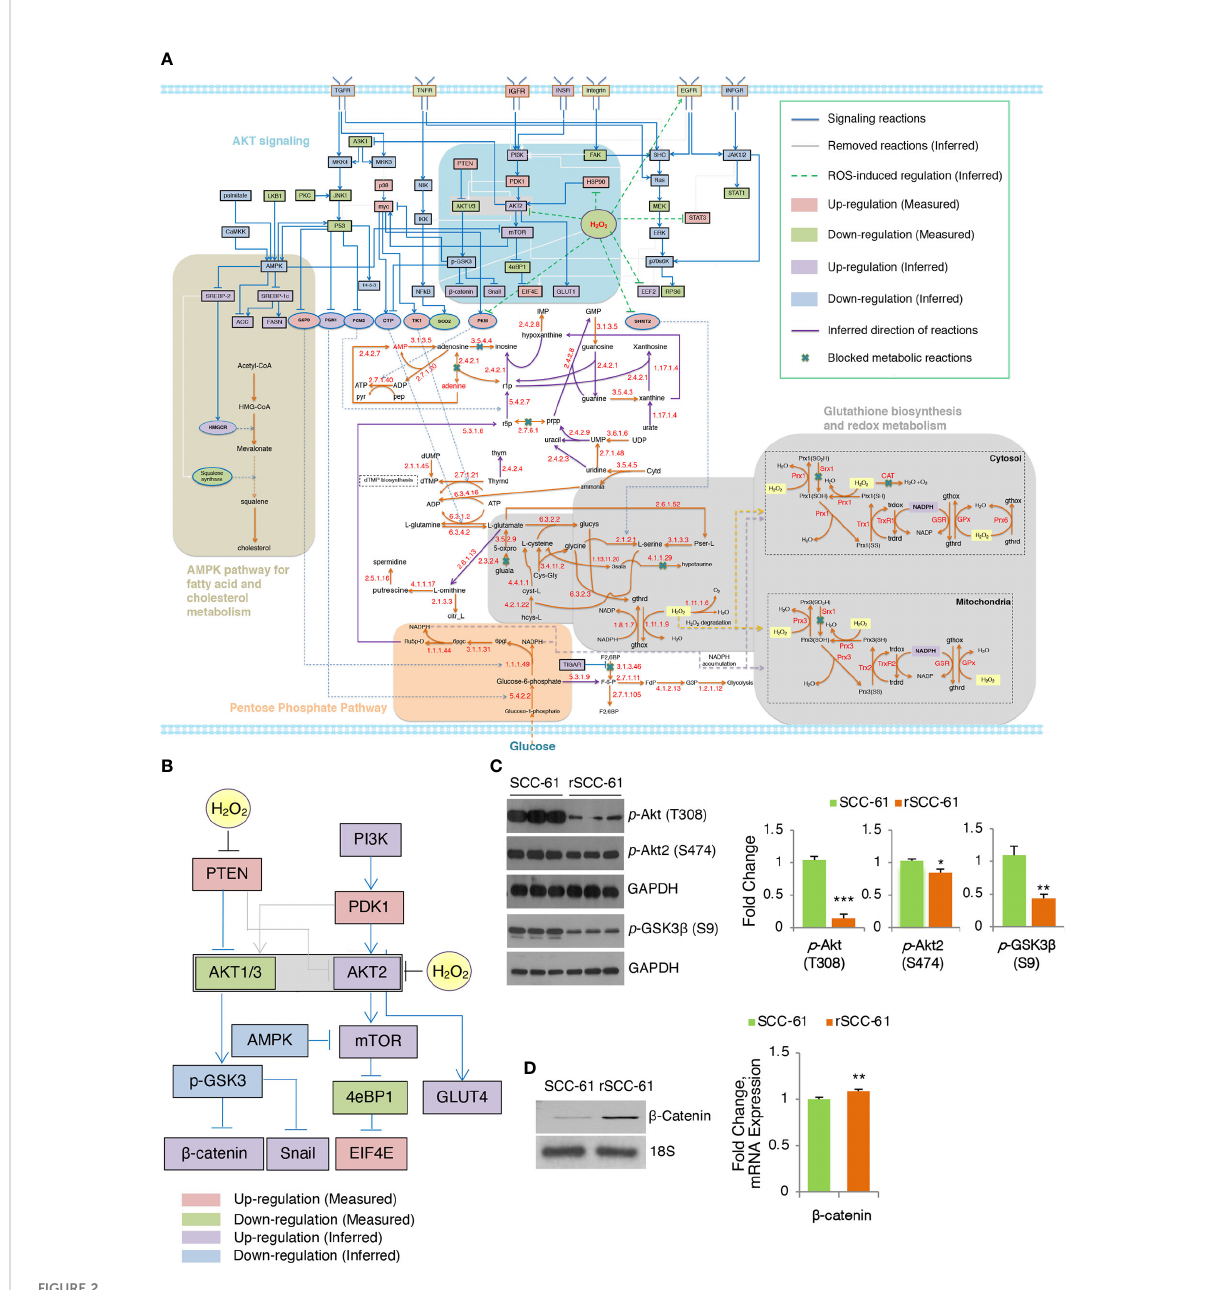
FIGURE 2 Inferred COSM ro network differentiating radiation resistant rSCC-61 from radiation sensitive SCC-61 Cells. (A) rSCC-61 speci fi c network inferred by COSM ro model. Measured and inferred activity of signaling proteins and inferred direction of metabolic reactions is presented with four radiation resistant network signatures highlighted. (B) Akt subnetwork showing predicted upregulation of Akt2 and b -catenin and downregulated pGSK3 b in radiation resistant rSCC-61 cells. (C) Western blot analysis of SCC-61 and rSCC-61 cell lysates with antibodies against pAkt (T308), pAkt2 (S474), pGSK3 b (S9), and GAPDH as a loading control to validate network prediction. Quanti fi cation is shown on the right panels. (D) RT-PCR analysis showing increased expression of b -catenin in rSCC-61 compared to SCC-61 (left) and mRNA data extracted from the previously reported